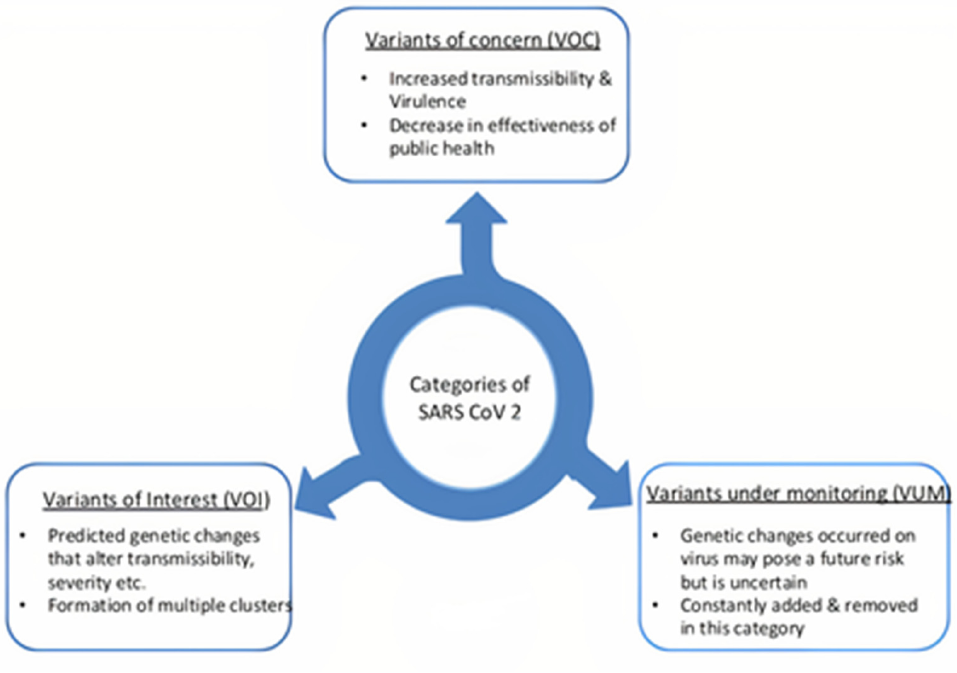
Figure 6. Salient features of SARS-CoV-2 categories.